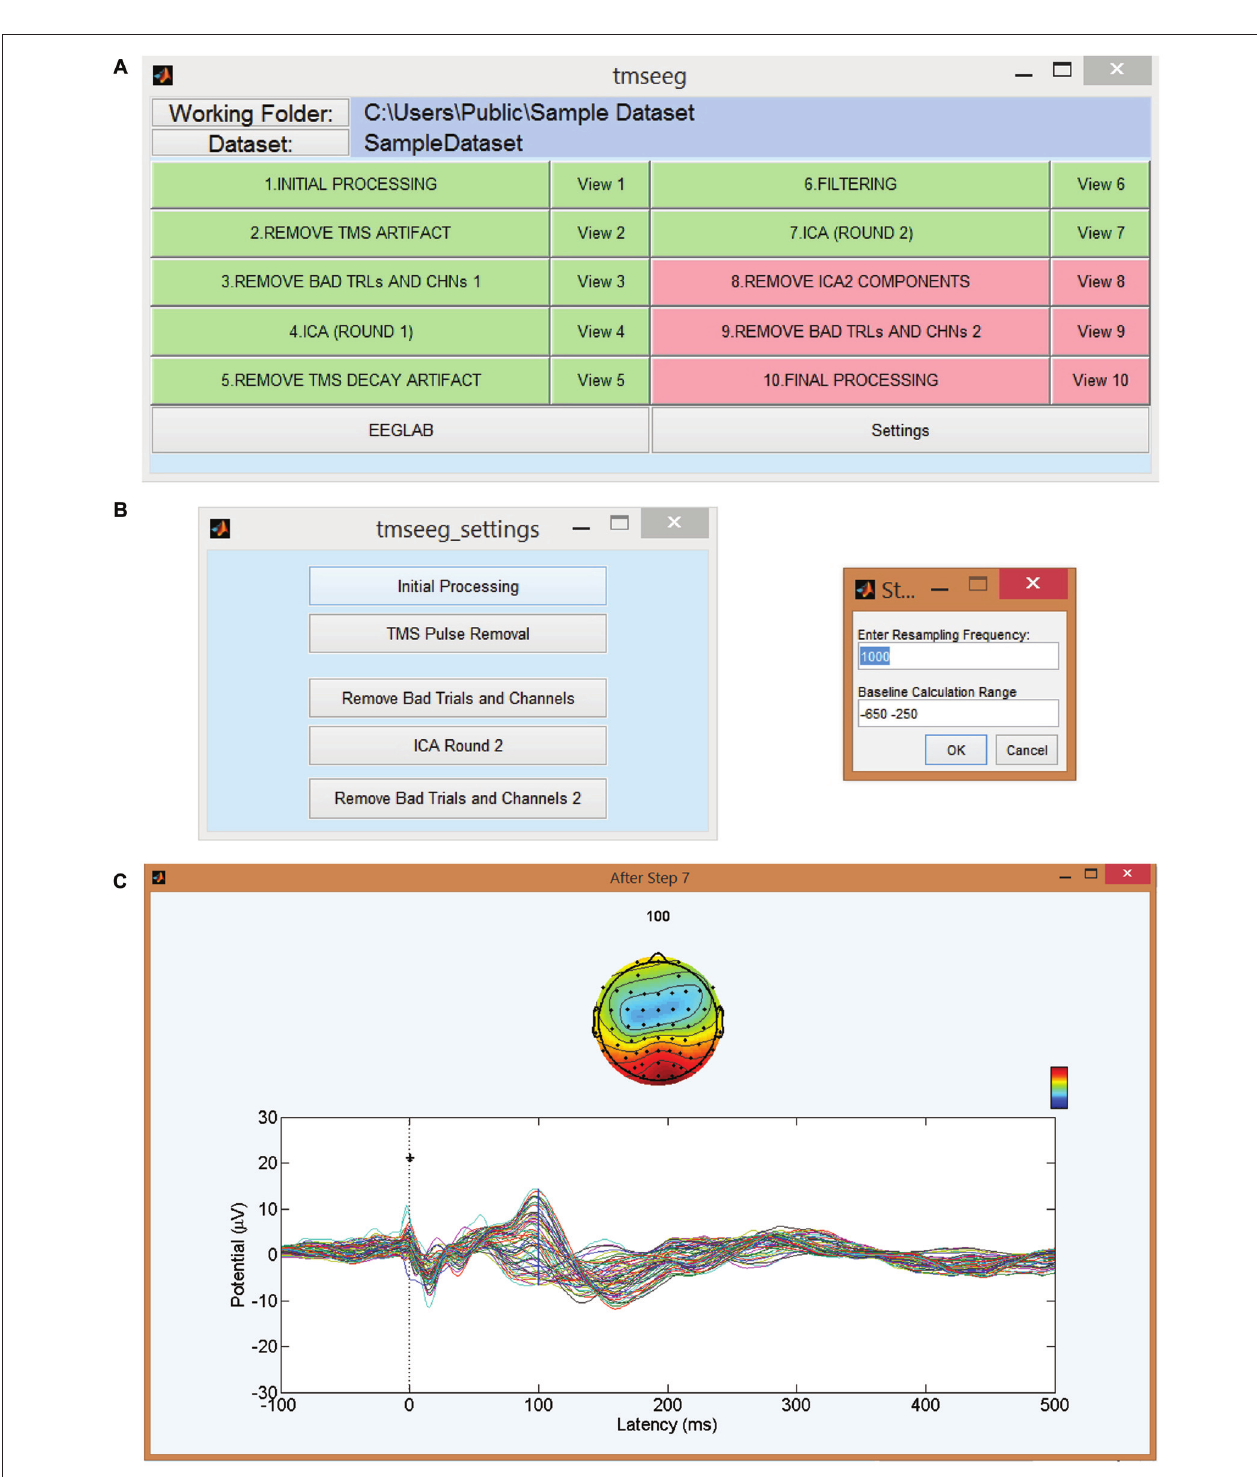
FIGURE 2 | TMSEEG main graphical user interface (GUI). (A) TMSEEG main GUI window comprised of a button for TMS-EEG file selection, 10 data processing buttons, 10 data View buttons, and two buttons for access to the Settings menu and EEGLAB toolbox. Data processing buttons are coded in red if a step is yet to be processed and changed to green at the completion of a step. (B) Users can change the default settings of any processing step in the corresponding Settings window. (C) Selecting the “View #” button next to a processing step will display the average butterfly plot illustrating TMS-evoked potentials (TEP)s at the completion of that step for a quality control check. X -axes represent time in milliseconds relative to presentation of TMS pulse and y -axes represent the amplitude of the EEG signal in µ V.